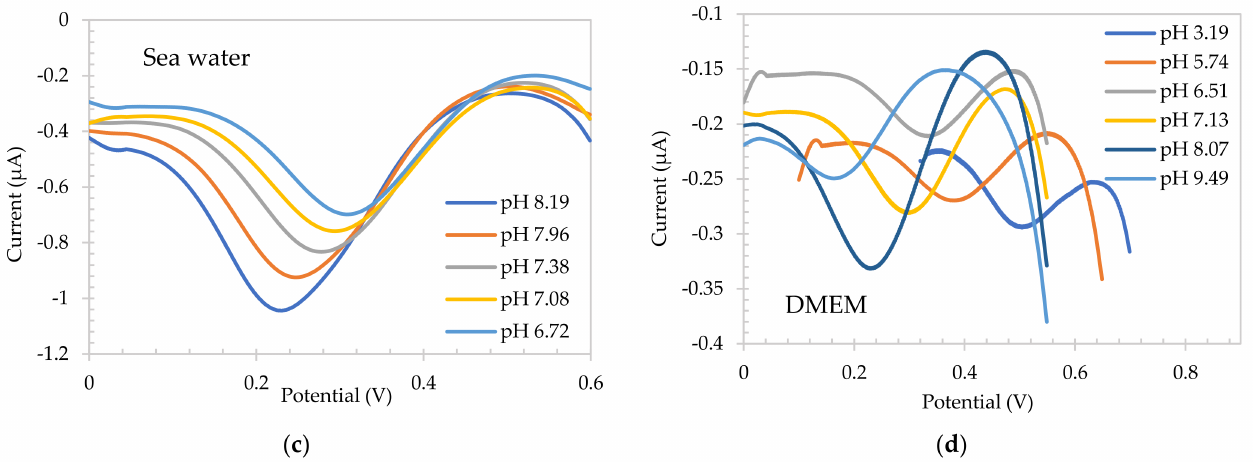
Figure 5. Square wave voltammograms for Flavanone-based electrodes in pH adjusted ( a ) soy sauce,